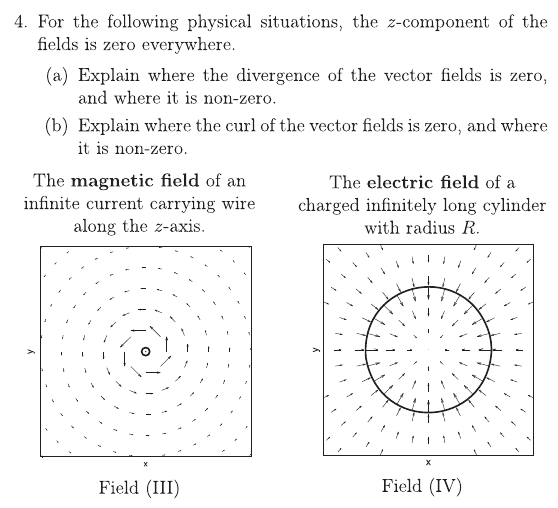
FIG. 9. Post-test question to determine whether students can decide where divergence and curl are nonzero in field vector plots of electromagnetic fields.